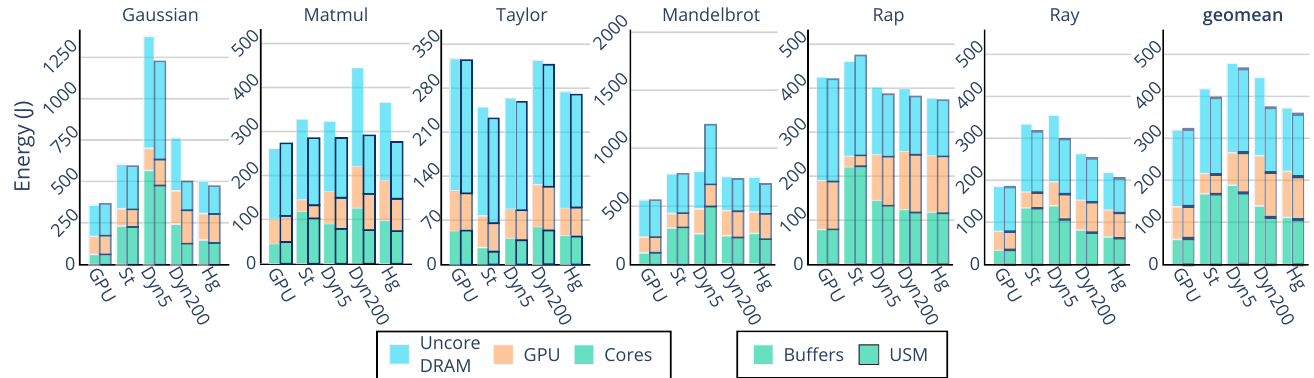
Figure 9. The energy consumption by cores, GPU, and the other units of the package with the DRAM consumption for the Desktop node.